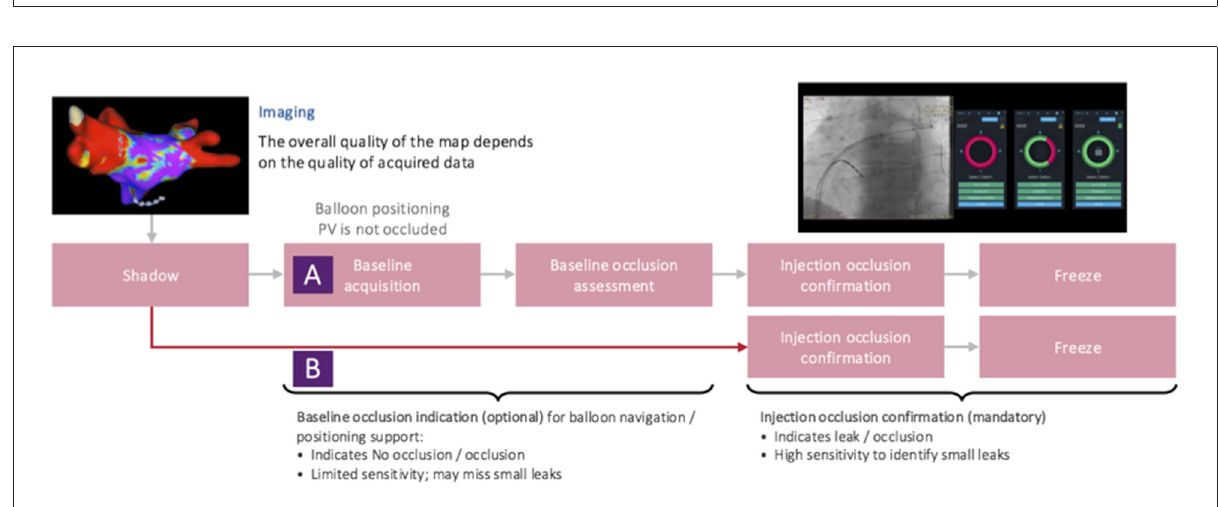
Data handling and statistical